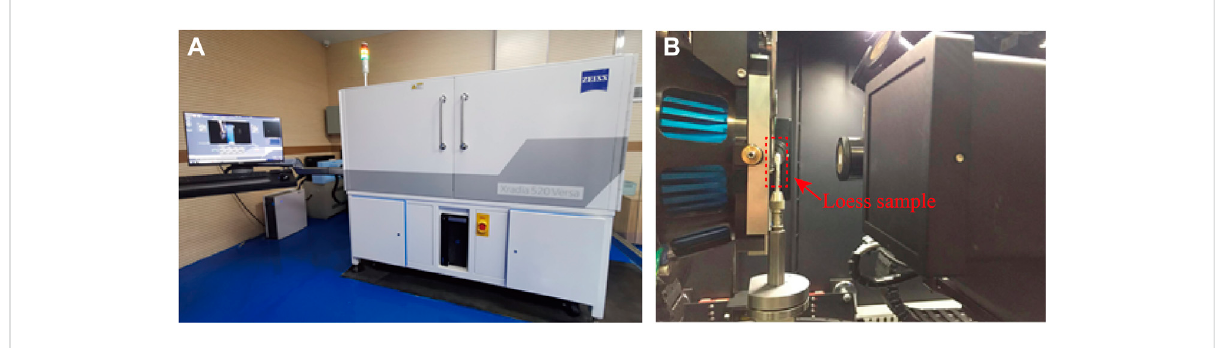
Micro-CT machine (A) and sample scanning stage (B) .